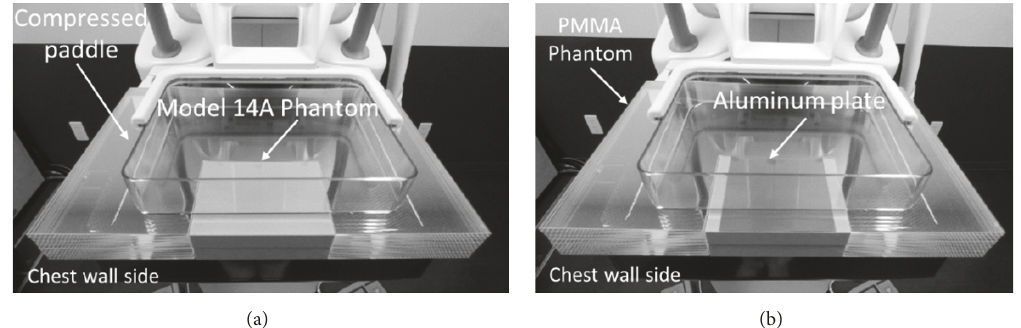
Figure 1: Experimental set up of the phantom for the CNR measurement based on the International Electrotechnical Committee guidelines (a) without and (b) with the aluminum plate placed at the center of the horizontal axis of the breast support. CNR: contrast to noise ratio and PMMA: polymethyl methacrylate.